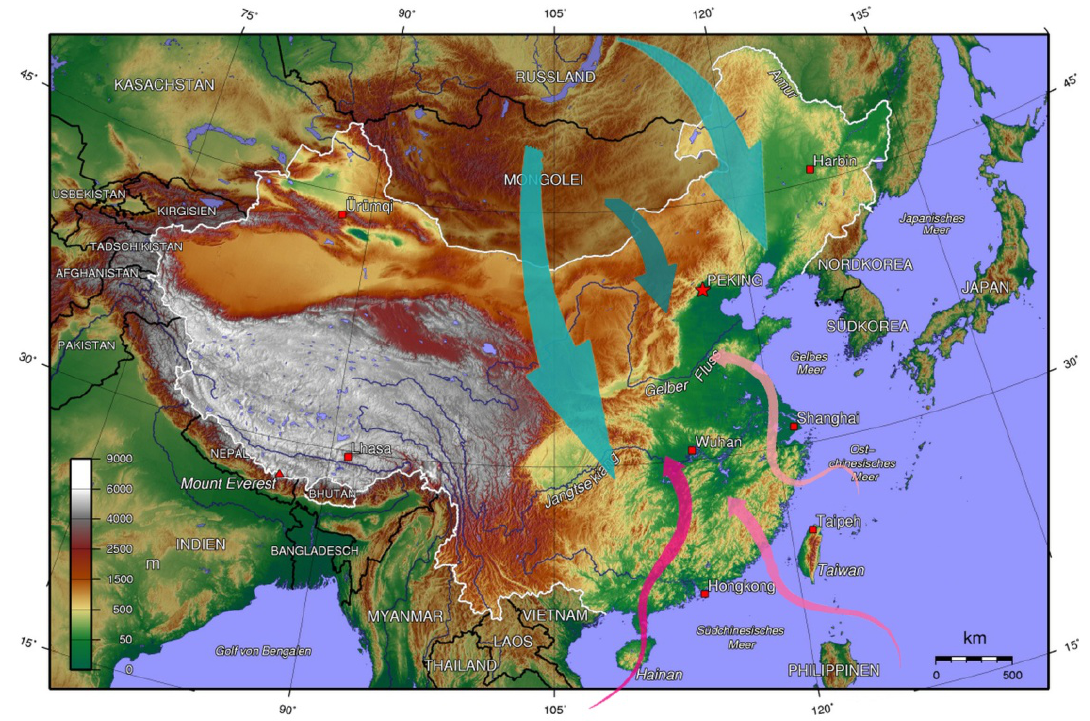
Figure 1. After China topography map